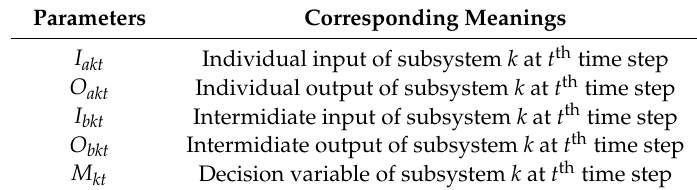
Figure A1. The subsystems of the water resources system. Table A1. System model